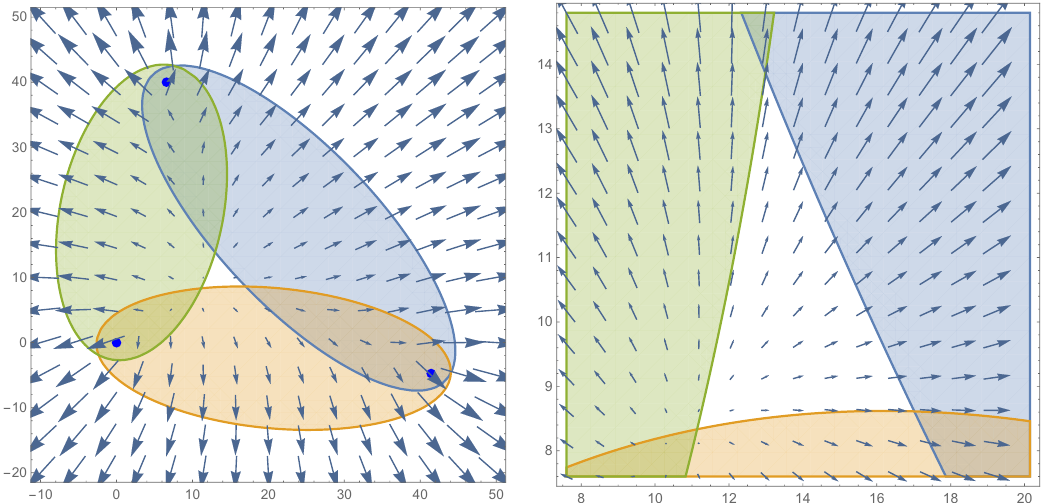
Figure 3. An example of an incorrect deformation vector (cid:12)eld constructed by adding the normal vector (cid:12)elds of three E-surfaces. The picture on the right is an enlargement of the problematic center region in the left image. This particular case requires (cid:12)ne-tuning of the normalisation of each of the three (cid:12)elds added in order to obtain a valid